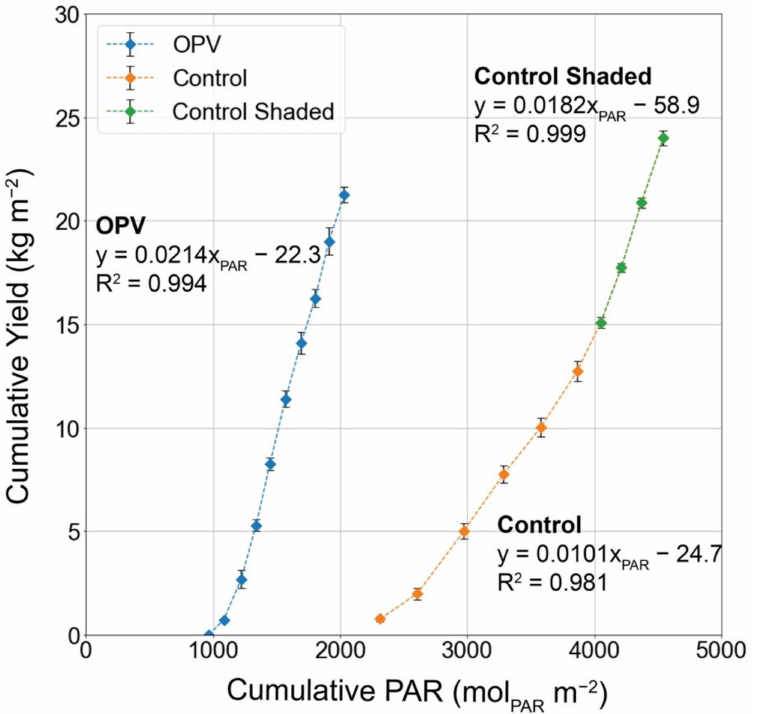
Figure 11. Cumulative yield (in kg m − 2 ) versus cumulative photosynthetically active radiation (PAR, in mol PAR m − 2 ) incident on the canopy in OPV and Control sections. Points represent the averaged values of 6 plants in each section, with bars representing the standard